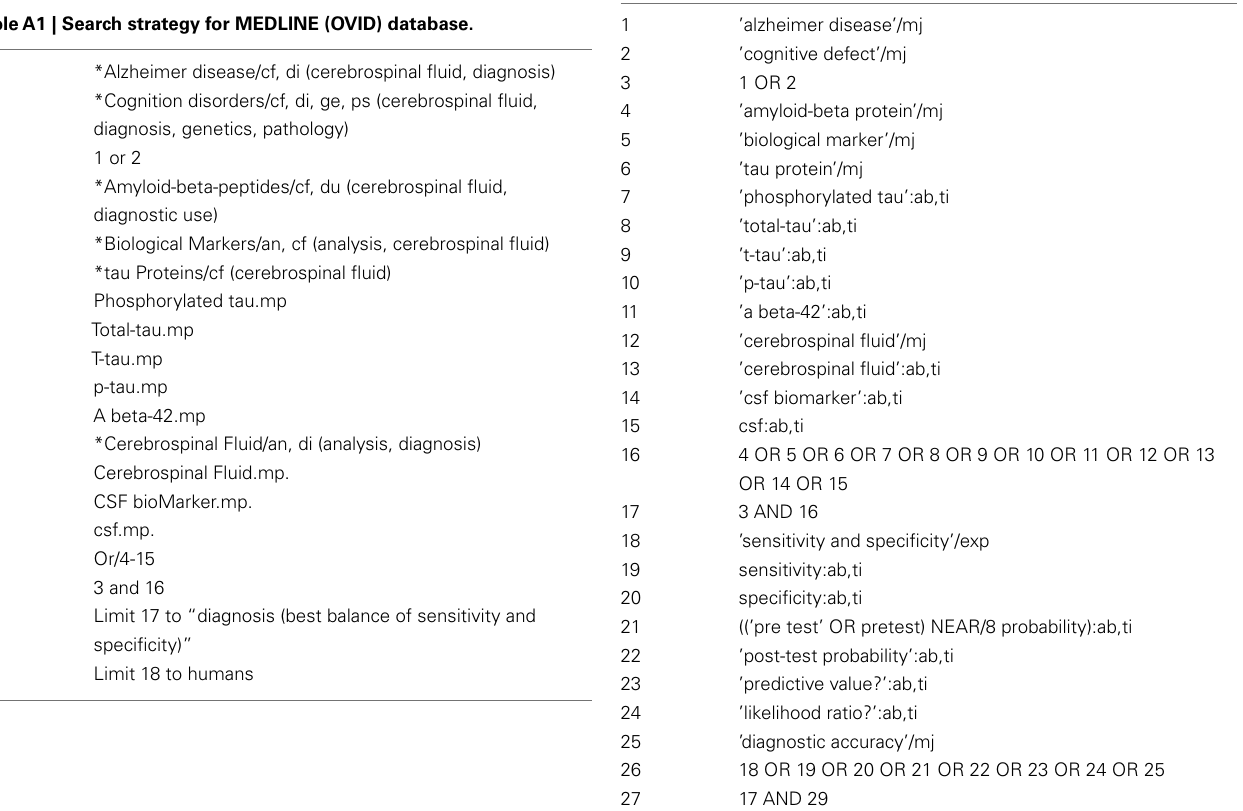
TableA2 | Search strategy for EMBASE (Elsevier)